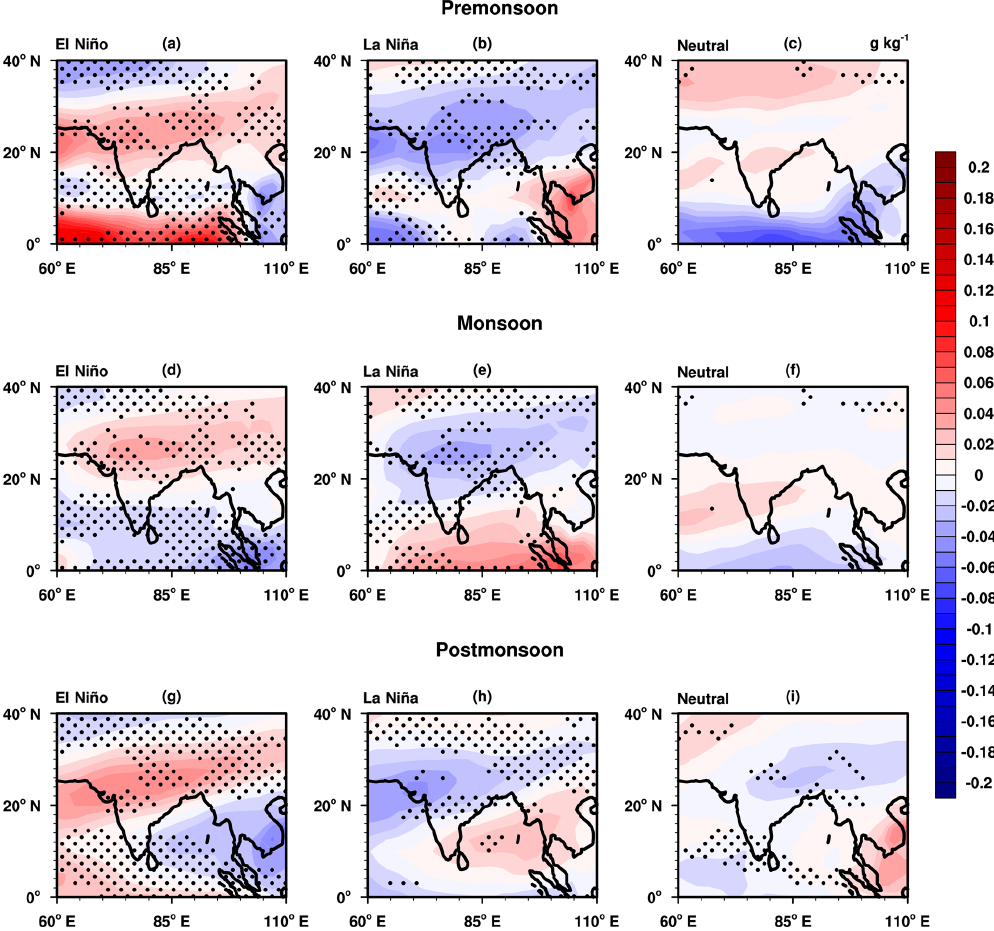
Figure 8. Anomaly composite of specific humidity at 300hPa during different ENSO phases with stippling to indicate statistically significant areas at a 95% confidence